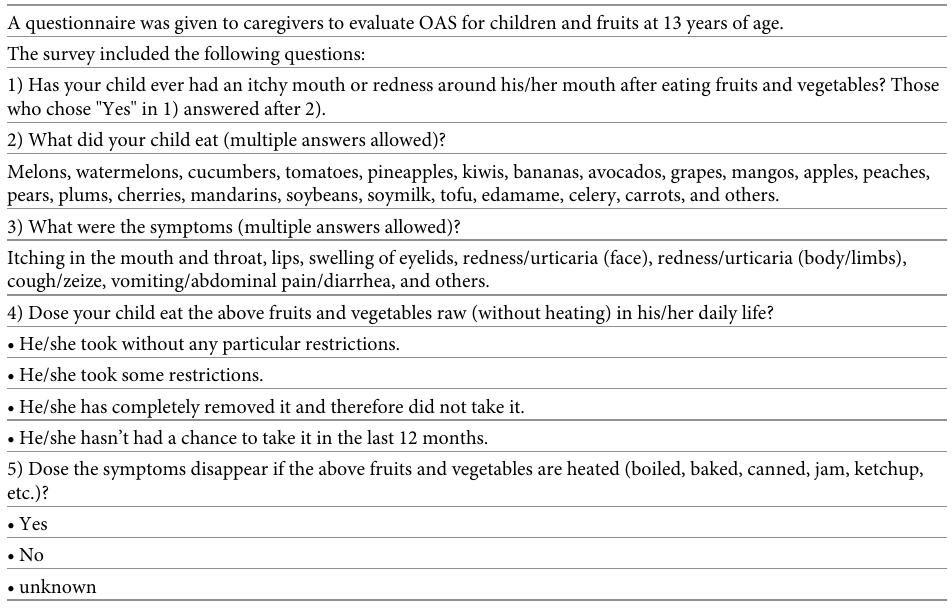
Table 2. Questionnaire items about oral allergy syndrome for fruits and vegetables. A questionnaire was given to caregivers to evaluate OAS for children and fruits at 13 years of age. The survey included the following